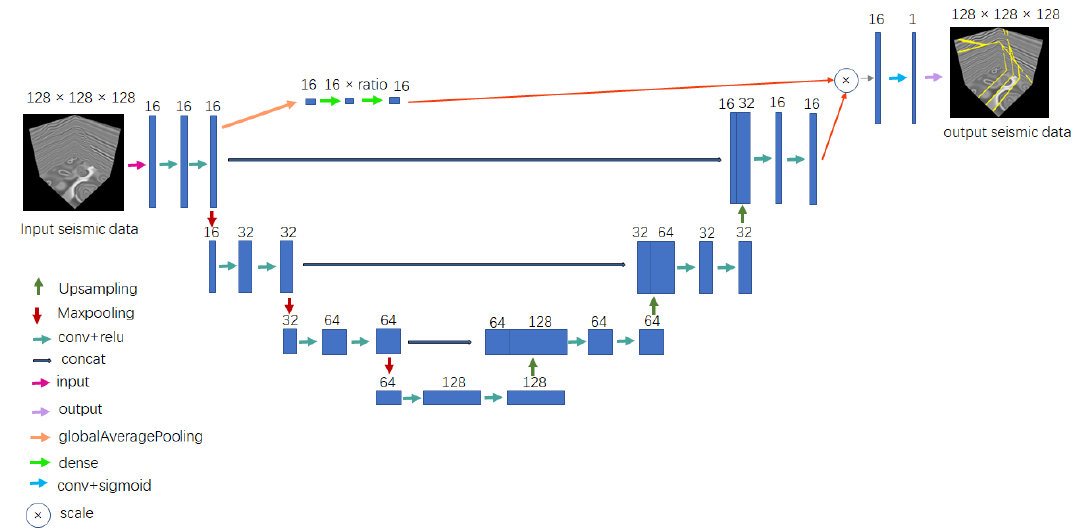
Figure 2. SE-UNet